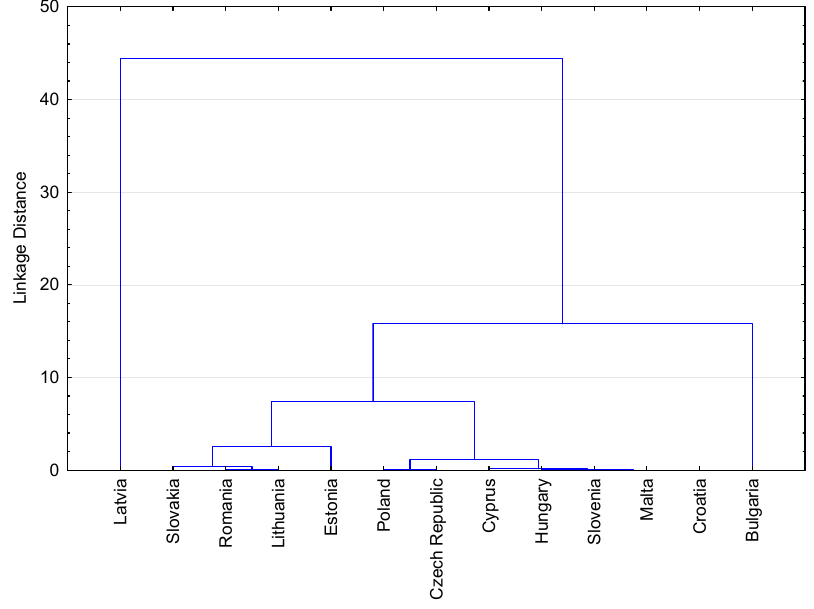
Figure 11. Tree diagram for IREN in 2004.